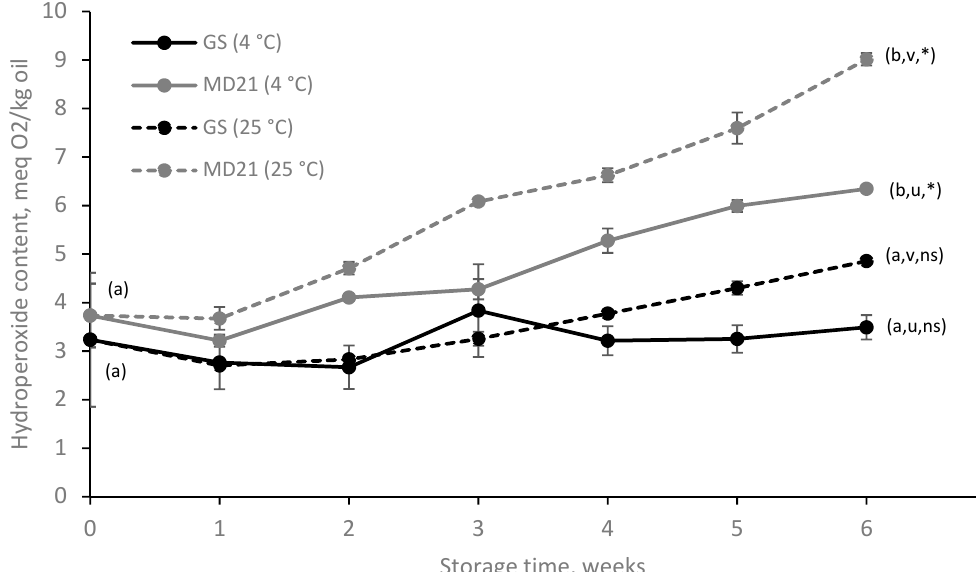
Figure 2. Peroxide value (PV) of spray-dried microcapsules loaded with fish oil during storage at: 4 ◦ C (solid line, — • —) and 25 ◦ C (broken line, - - • - -) encapsulated with glucose syrup (black) or maltodextrin (grey). Means within the same sampling point followed by a letter, a-b, indicates statistical di ff erences ( p ≤ 0.05) between encapsulating agents for the same storage temperature. Means within the same sampling point followed by a letter, u-v, indicates statistical di ff erences ( p ≤ 0.05) between storage temperatures for the same encapsulating agent. Means within the same sample followed by an asterisk (*) indicates statistical di ff erences ( p ≤ 0.05) between week 0 and week 6. Means within the same sample followed by “ns” indicates no statistical di ff erences ( p > 0.05) between week 0 and week 6.